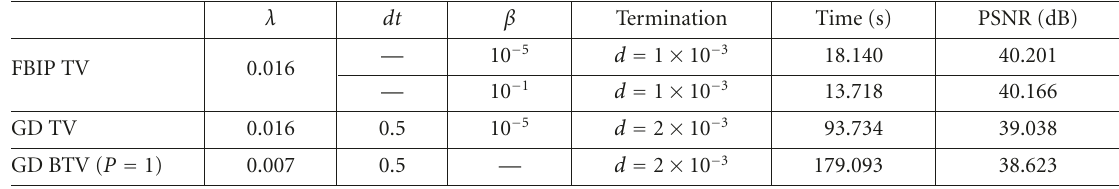
Table 2: Comparison with GD TV and BTV algorithms in the synthetic “noise-free” case (2 frames).